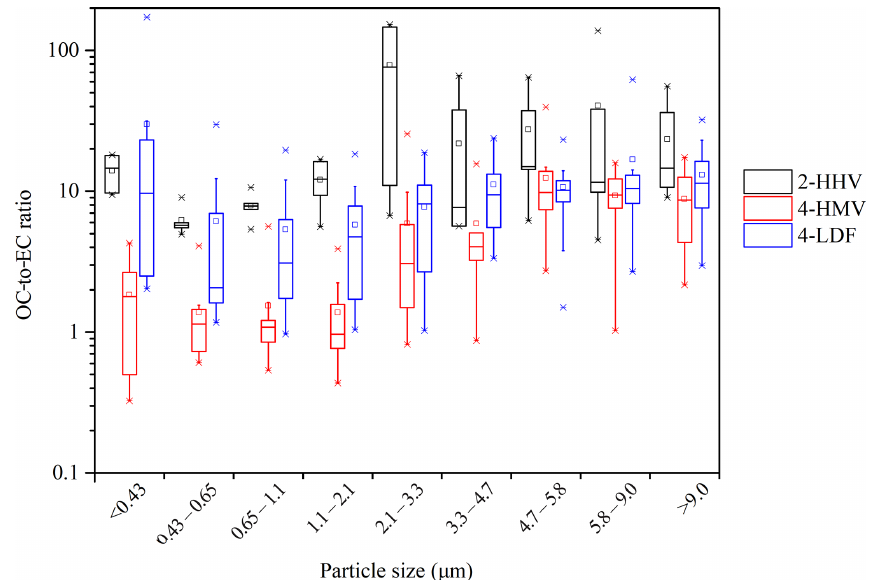
Figure 4. OC/EC ratio in different particle-size